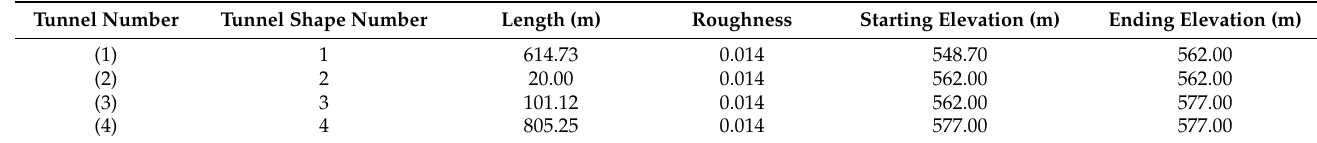
Table 1. Tunnel parameters.